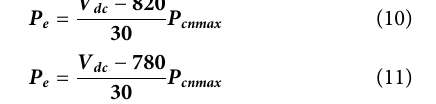
The red line in the fi gure indicates the actual user load on both sides of the system, and the green line indicates the output power line indicates the SOC variation curve of BESS.